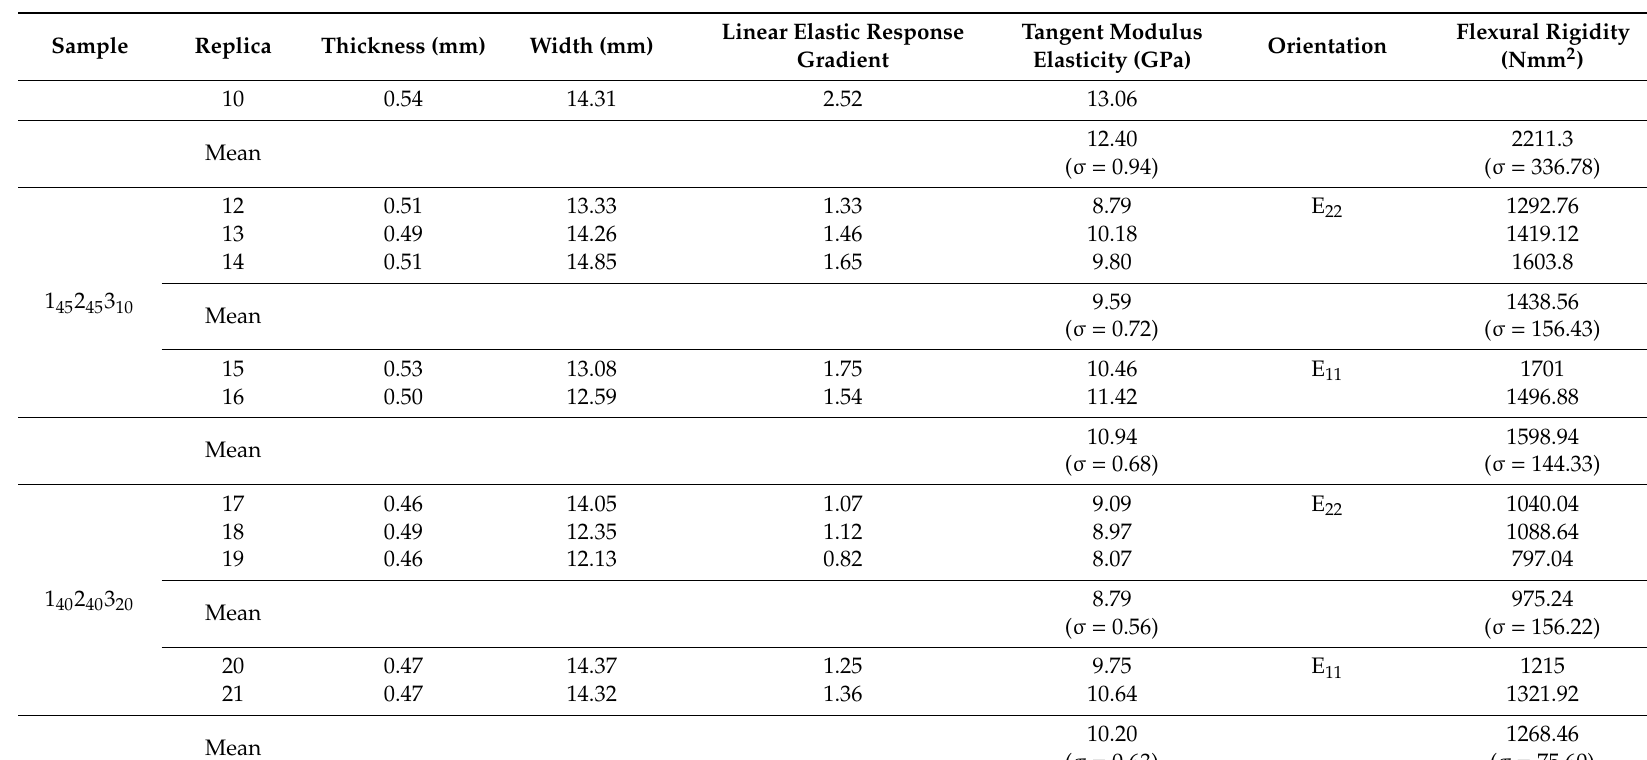
Table 5. Dimensions obtained from the 3-point bending test for specimens and the calculated tangent moduli of elasticity.